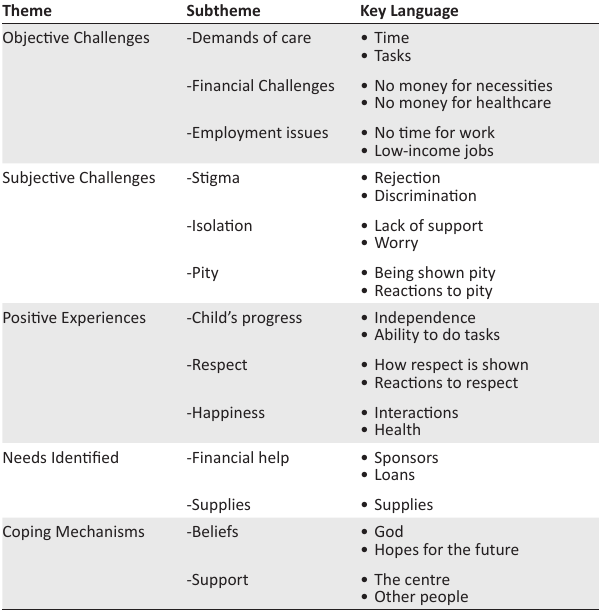
TABLE 2: The table below shows the themes and subthemes that emerged from the data. Theme Subtheme Key